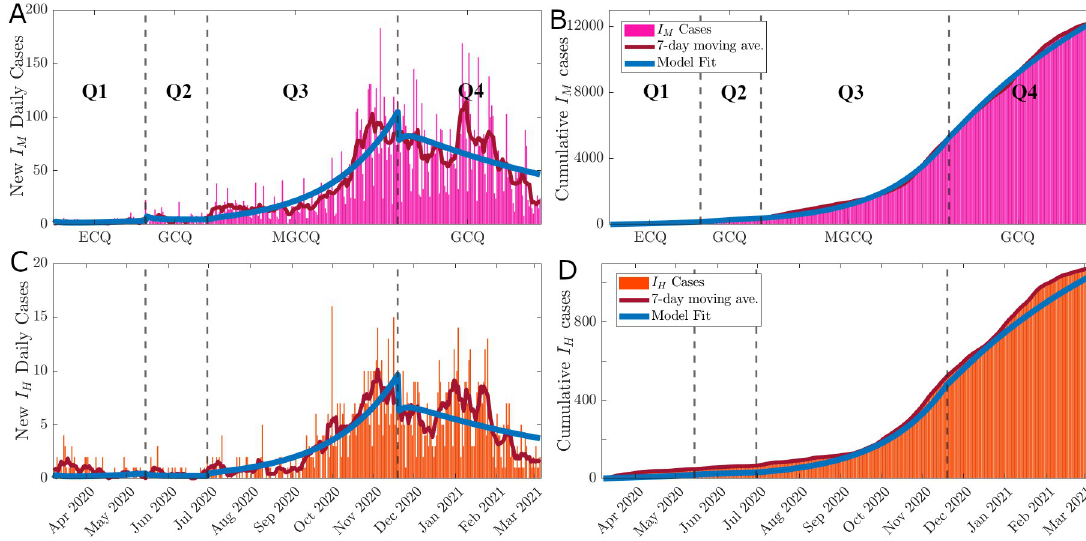
Fig 3. The best fit of the SEI model to the daily new cases according to health status upon admission. The four quarantine H I M R periods are separated by broken lines. The bars are the daily new incidence data in Davao City, while the solid blue line corresponds to the model simulations. It shows the model fit vs daily data (A), the model fit vs. cumulative data for monitored cases (B), the model fit vs. daily data (C), and the model fit vs. cumulative data for hospitalized cases (D).